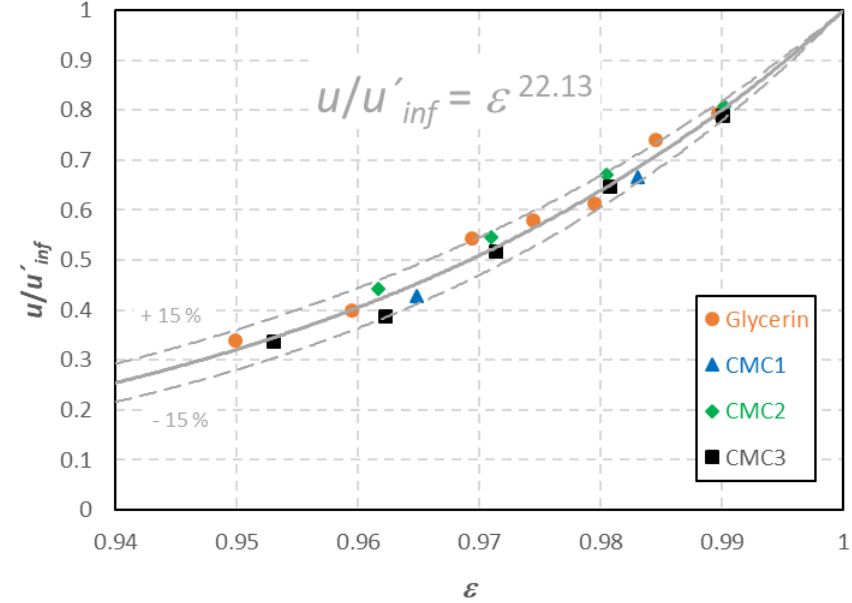
Figure 7. Dependence of the hindered settling velocity of the cloud of the fiber suspension on the porosity of the suspension cloud.